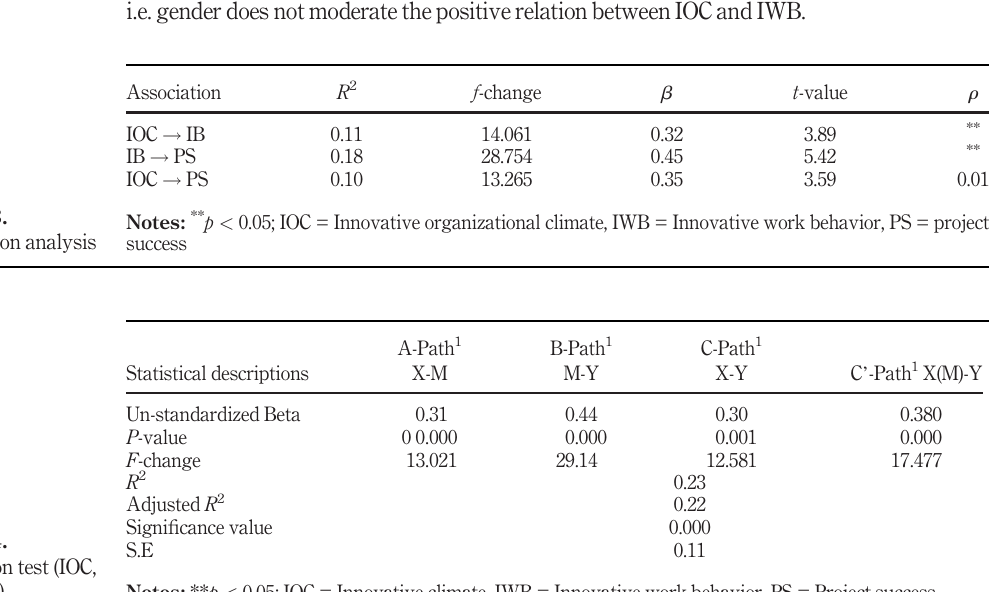
Table 4. Mediation test (IOC, IWB, PS)